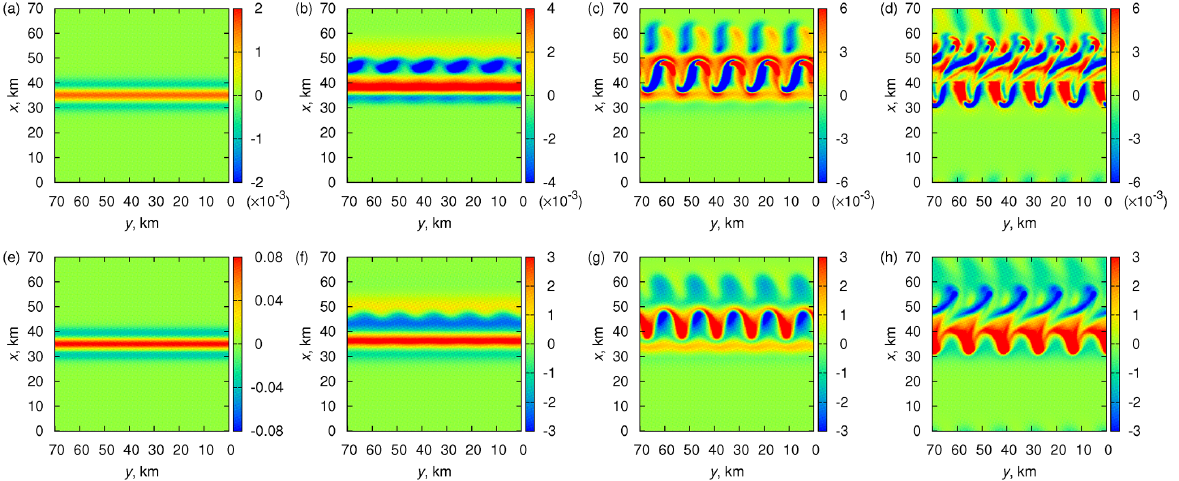
Figure 3. Same plots as Fig. 2 but for (a – d) field-aligned current j (cid:107) and (e – h) electron density n e at the ionosphere s = 0. The unit of j (cid:107) is normalized by 650µAm − 2 , i.e., 10 − 3 equals 0.65µAm − 2 . See text for n e